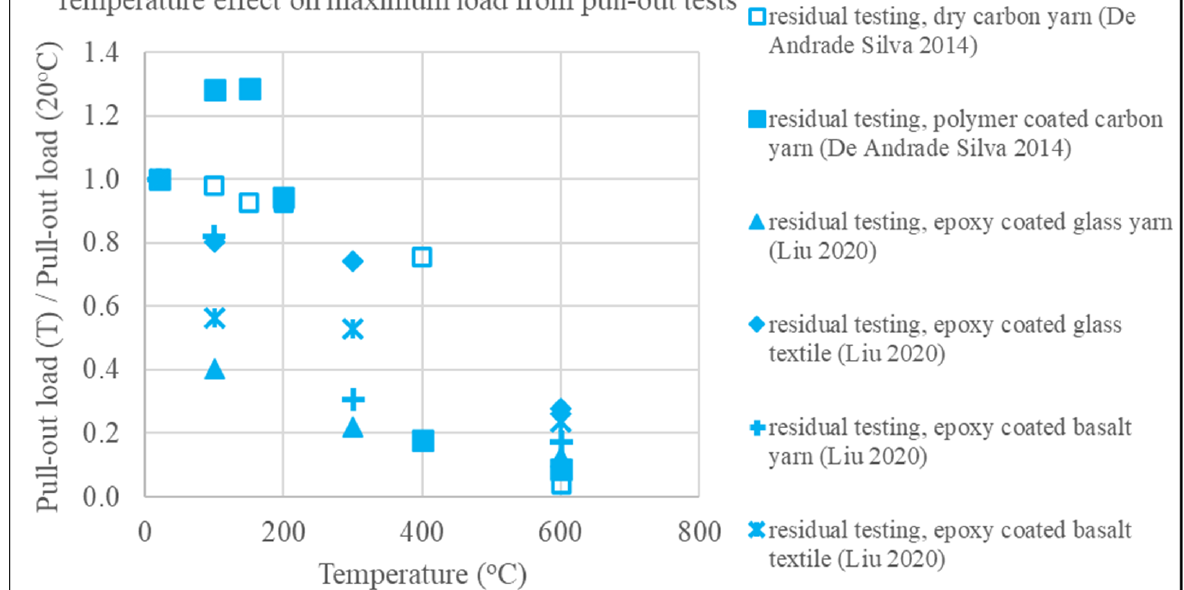
Figure 1. Influence of exposure temperature on the maximum pull-out load on TRC specimens.